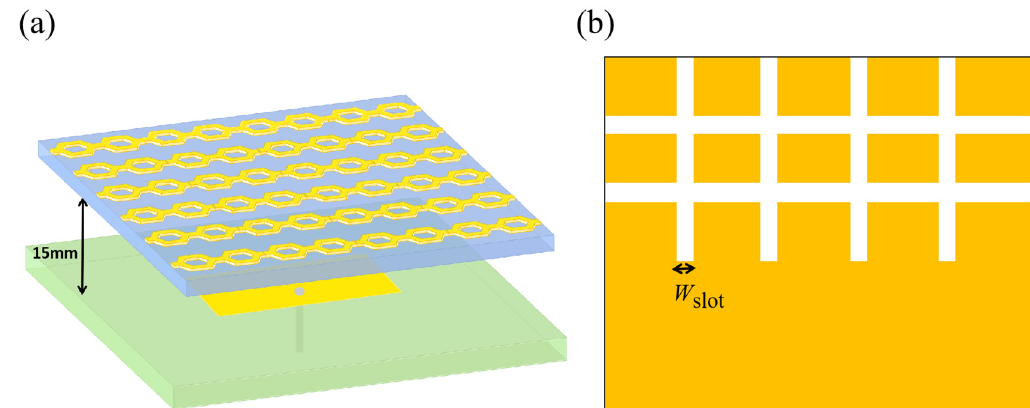
Figure 3. Schematic diagram of a cascaded hexagonal ring-shaped metamaterial slot microstrip antenna ( a ) Three-dimensional view; ( b ) Schematic diagram of the ground plate with etched slots.